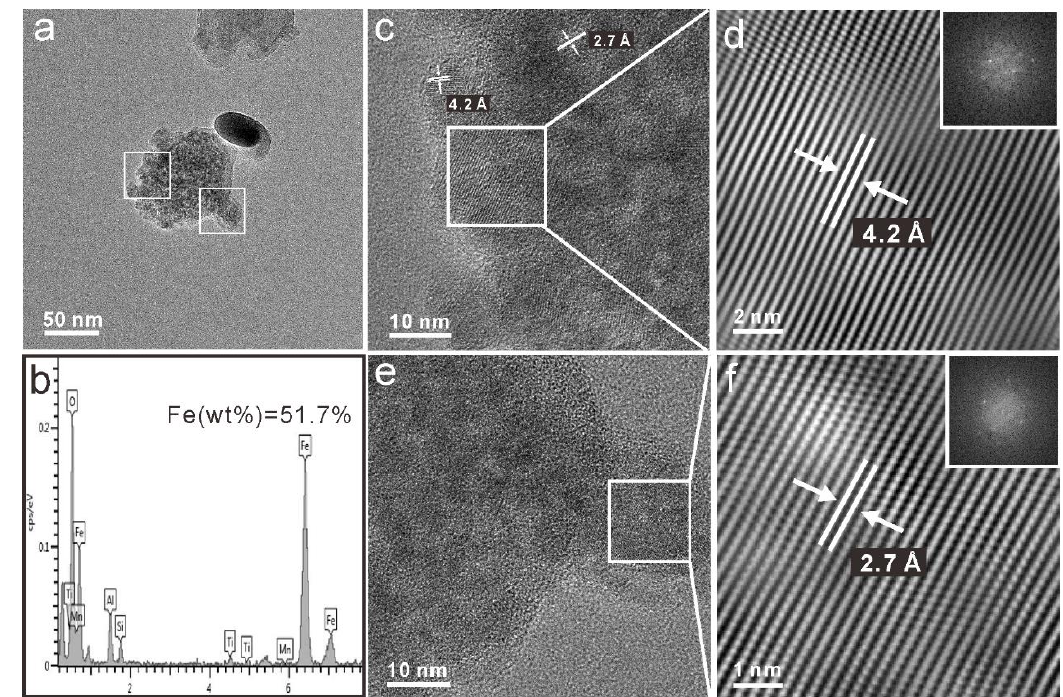
Figure 5. TEM morphology ( a ), chemical composition ( b ), lattice photograph ( c , e ) and diffraction pattern ( d , f ) of Fe-rich grains in the soil Fe/Mn coating. Panel ( b ) shows the chemical composition of the Fe-rich nanocrystal aggregate. The lattice fringes and diffraction patterns in panels ( d ) and ( f ) are the FFT and inverse FFT results of selected rectangular regions in panels ( c ) and ( e ), respectively.